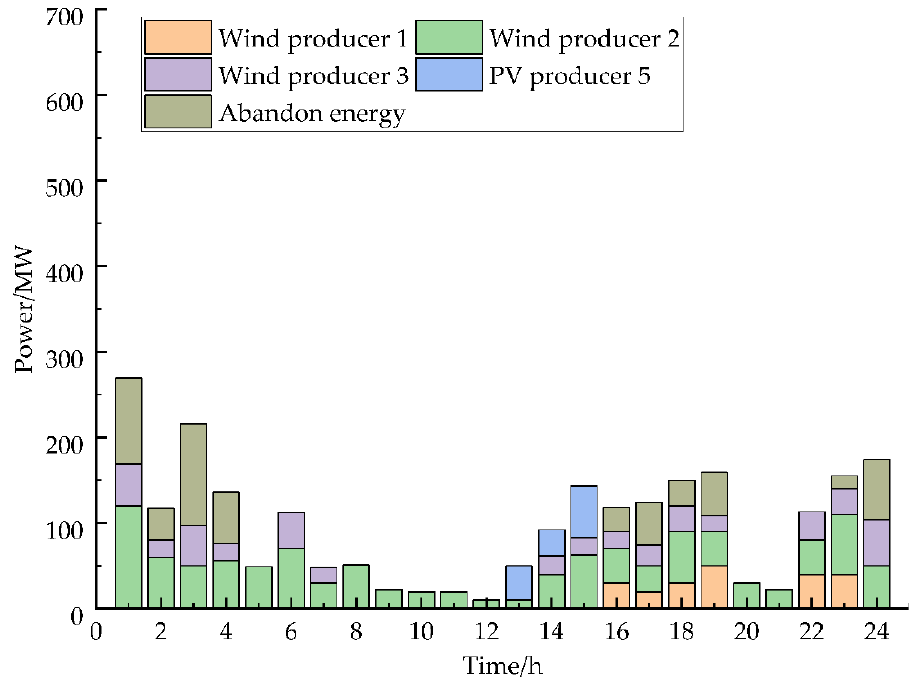
Figure 5. Output of each producer after first clearing.